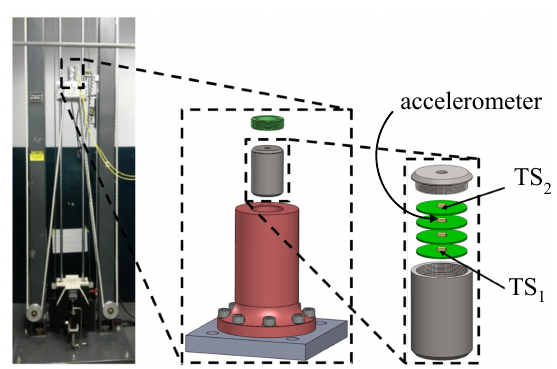
Figure 4. Drop tower experimental setup